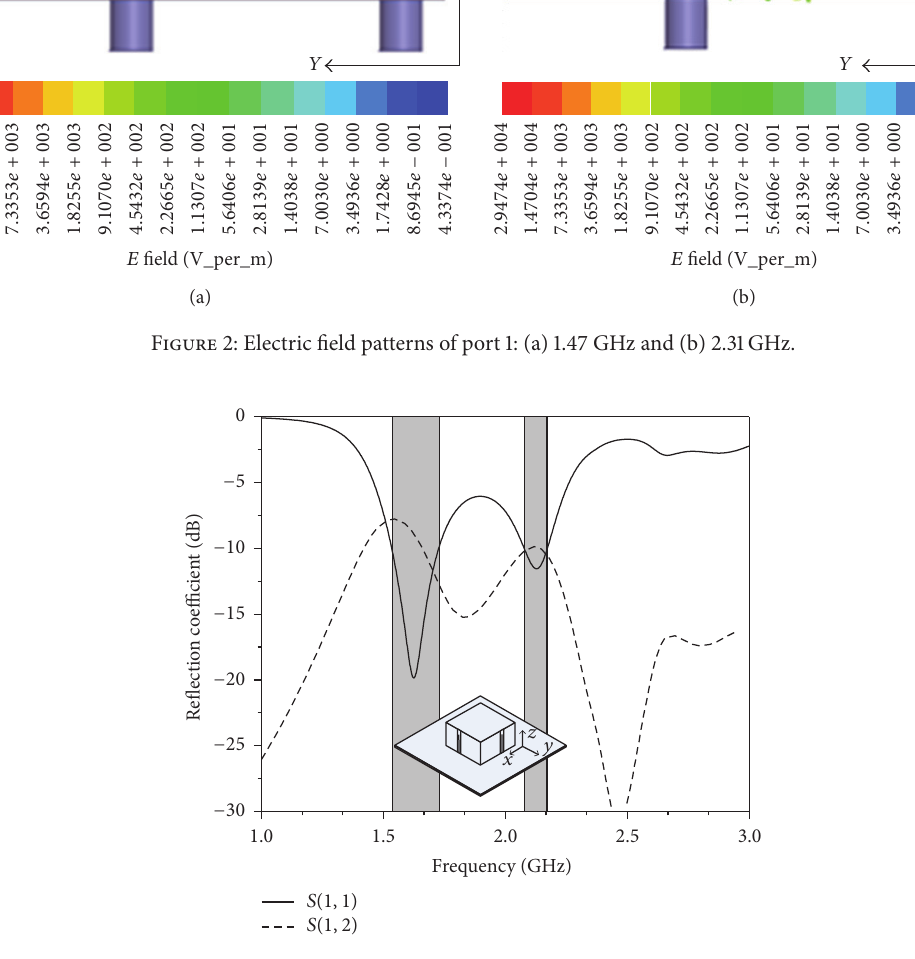
Figure 3: Simulated reflection coefficient with dimensions calculated using